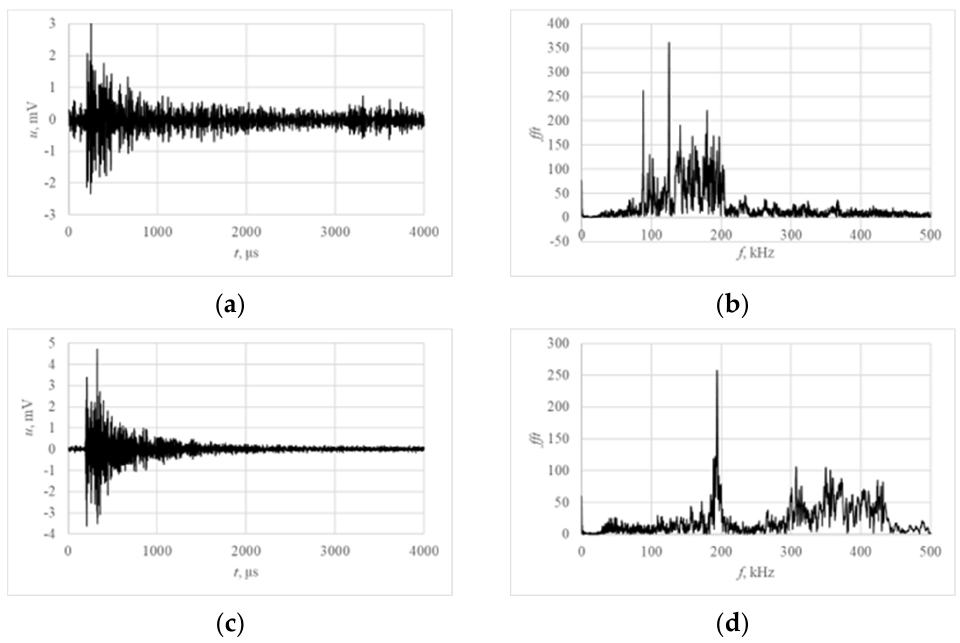
Figure 5. Typical waveform ( a , c ) and spectrums ( b , d ) of AE signals obtained during the loading of defect-free specimens.